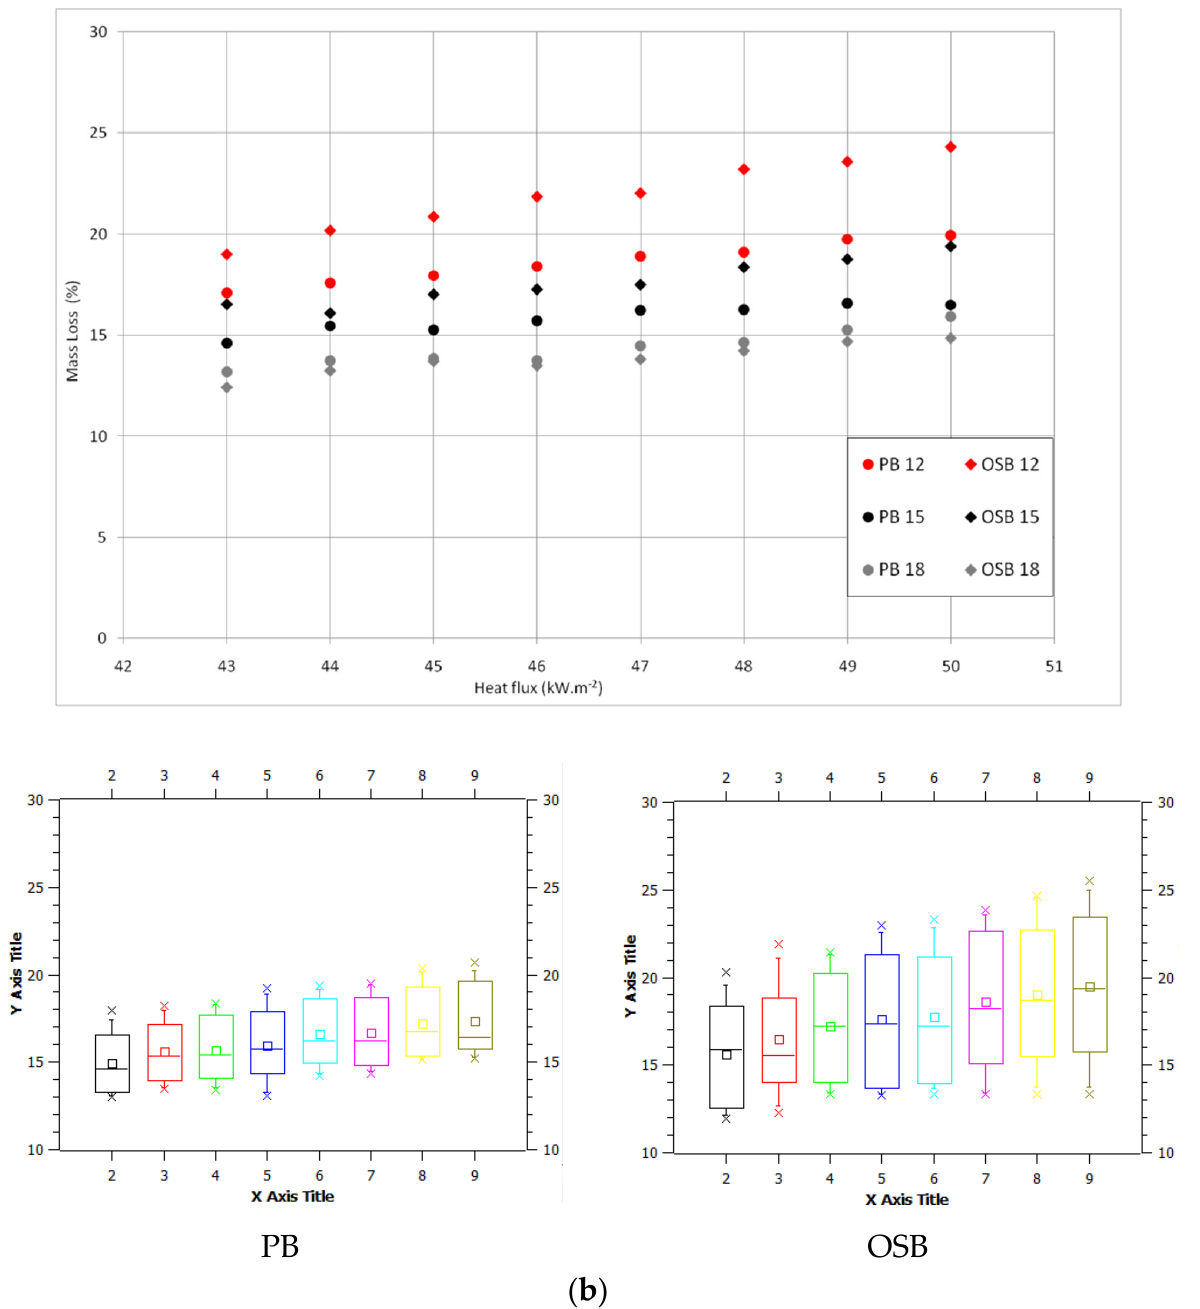
Figure 5. Comparison of time-to-ignition and mass loss values of particleboards and OSB depending on the heat flux values. ( a ) Comparison of time-to-ignition results with box graph, where X Axis is heat flux 43–50 kW.m − 2 and Y Axis is time-to-ignition for PB and OSB samples. ( b ) Comparison of mass loss results with box graph, where X Axis is heat flux 43–50 kW.m − 2 and Y Axis is mass loss for PB and OSB samples. Legends: PB 12—PB samples with 12 mm thickness, PB 15—PB samples with 15 mm thickness, PB 18—PB samples with 18 mm thickness, OSB 12—OSB samples with 12 mm thickness, OSB 15—OSB samples with 15 mm thickness, OSB 18—OSB samples with 18 mm thickness. Box graphs have X Axis marks as 2—43 kW.m − 2 ; 3—44 kW.m − 2 ; 4—45 kW.m − 2 ; 5—46 kW.m − 2 ; 6—47 kW.m − 2 ; 7—48 kW.m − 2 ; 8—49 kW.m − 2 ; and 9—50 kW.m − 2 . Confidential interval 95%. The values of time-to-ignition and mass loss of OSB have a greater dispersion of results, as evidenced by the created box graphs (Figure 5). The variability results